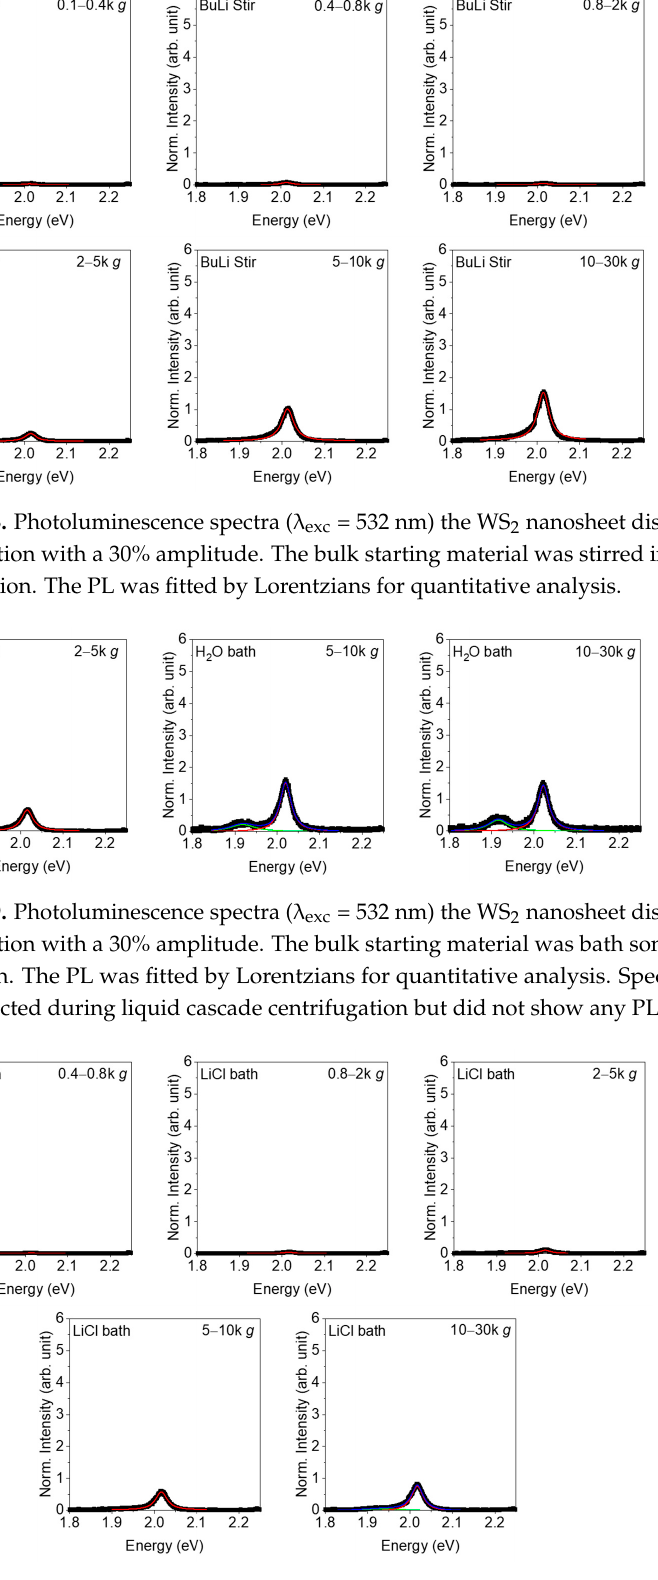
Figure A10. Photoluminescence spectra ( λ exc = 532 nm) the WS 2 nanosheet dispersions, exfoliated by tip sonication with a 30% amplitude. The bulk starting material was bath sonicated in H 2 O/LiCl prior to exfoliation. The PL was fitted by Lorentzians for quantitative analysis. Spectra of fractions which were collected during liquid cascade centrifugation but did not show any PL are excluded.